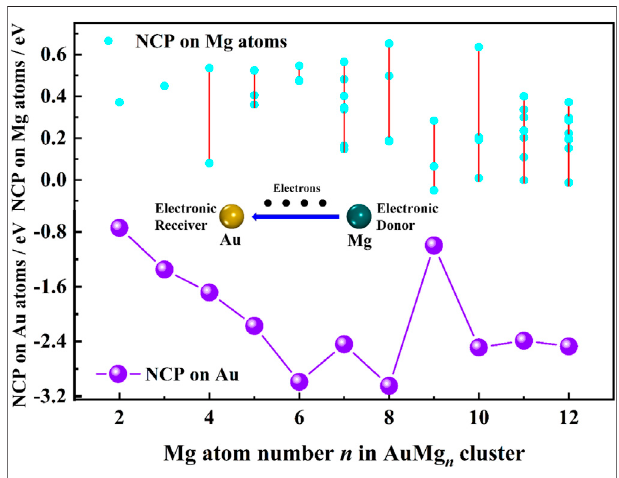
FIGURE 4 | NCP analysis on Au and Mg atoms in the ground state of AuMg n ( n = 2 – 12)